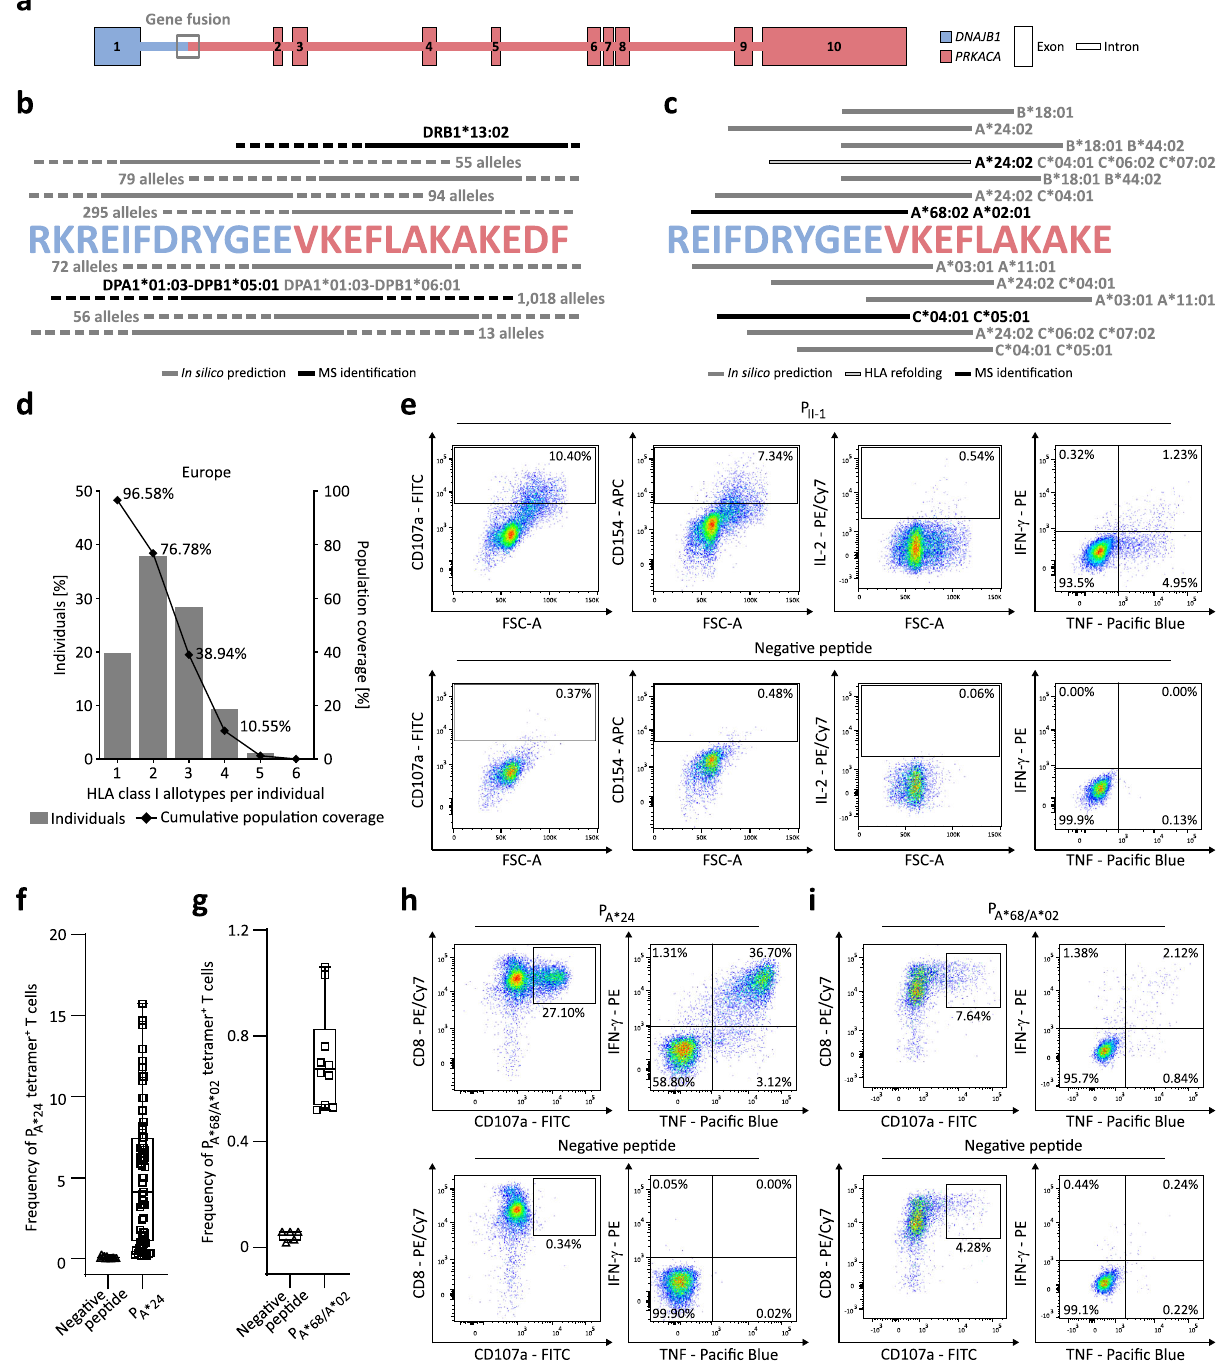
Doxycycline-inducible DNAJB1-PRKACA fusion gene expression leads to cellular processing and presentation of DNAJB1- PRKACA-derived HLA class I- and HLA class II-restricted peptides Three HLA class I-expressing hepatocellular carcinoma (HCC) cell lines (HLE, SMMC-7721, and HepG2; Supplementary Table 3) were trans- duced with an expression construct that allowed the Doxycycline (Dox)-dependent expression of the DNAJB1-PRKACA fusion protein (Fig. 3a, b, Supplementary Fig. S3a). Subsequent MS-based immuno- peptidome analysis revealed up to 3688 different HLA class I ligands (mean 2787; Fig. 3c). Twenty unique HLA class I ligands derived from the DNAJB1-PRKACA fusion protein were identi fi ed in the three